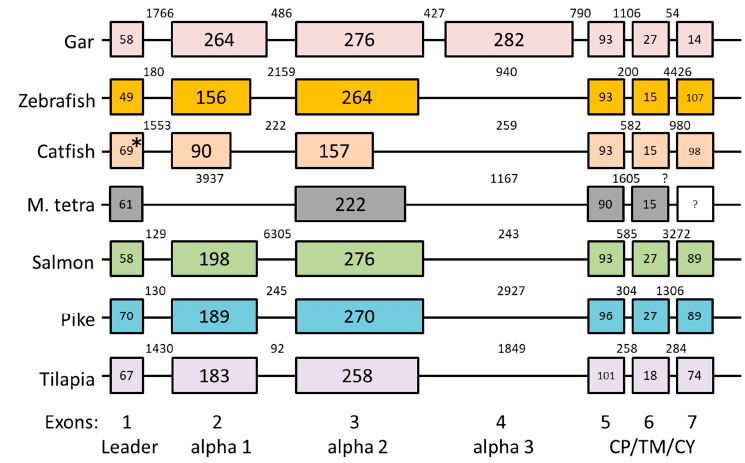
Figure 3. Exon-intron organization of selected HAA genes. Exons are shown as differently colored boxes for H lineage genes in Spotted gar ( Lepisosteus oculatus ), Zebrafish ( Danio rerio ), Channel catfish ( Ictalurus punctatus ), Mexican tetra ( Astyanax mexicanus ), Atlantic salmon ( Salmo salar ), Northern pike ( Esox Lucius ), and Tilapia ( Oreochromis niloticus ). The last exon of Mexican tetra found in different cDNA sequences was not present in the currently assembled GenBank genome sequence (Supplementary Text S1 and Text S2) and thus is presented as an uncolored box with question marks as to exon and intron sizes. Because of small differences between genomic and cDNA sequence reports, it was impossible to correctly align the first exon-intron boundary of the catfish HAA gene sequence, which is highlighted by an asterisk. Numbers within blocks indicate nucleotide lengths of the coding parts of exons, and numbers between blocks indicate intron lengths. Numbers at the bottom of the figure refer to MHC-I exon consensus numbers, with a description of their encoded domains.